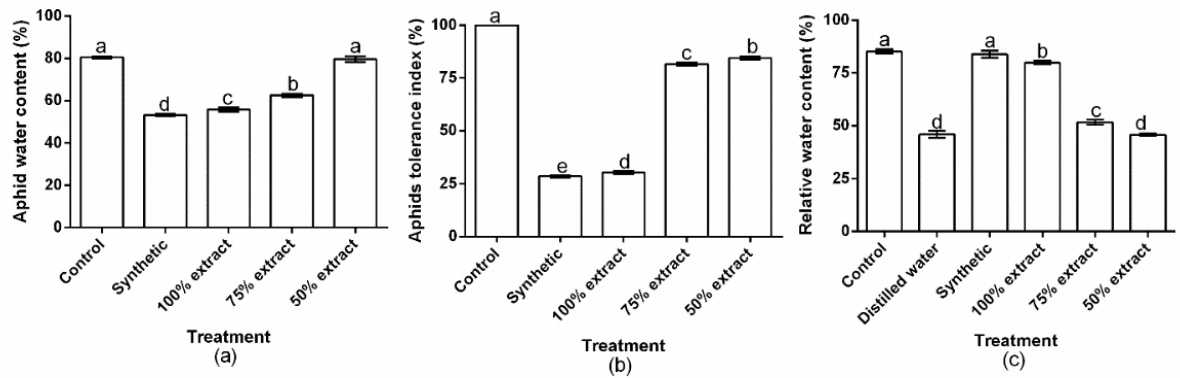
Figure 3. Effect of potato leaf extract on ( a ) aphid water content, ( b ) aphid tolerance index, and ( c ) relative water content. Data represent the mean ± standard deviation of three replicates. Lowercase letters indicate means that are significantly different according to the LSD test ( p < 0.05). Note: synthetic pesticide (recommended rate of Beta cypermethrin).